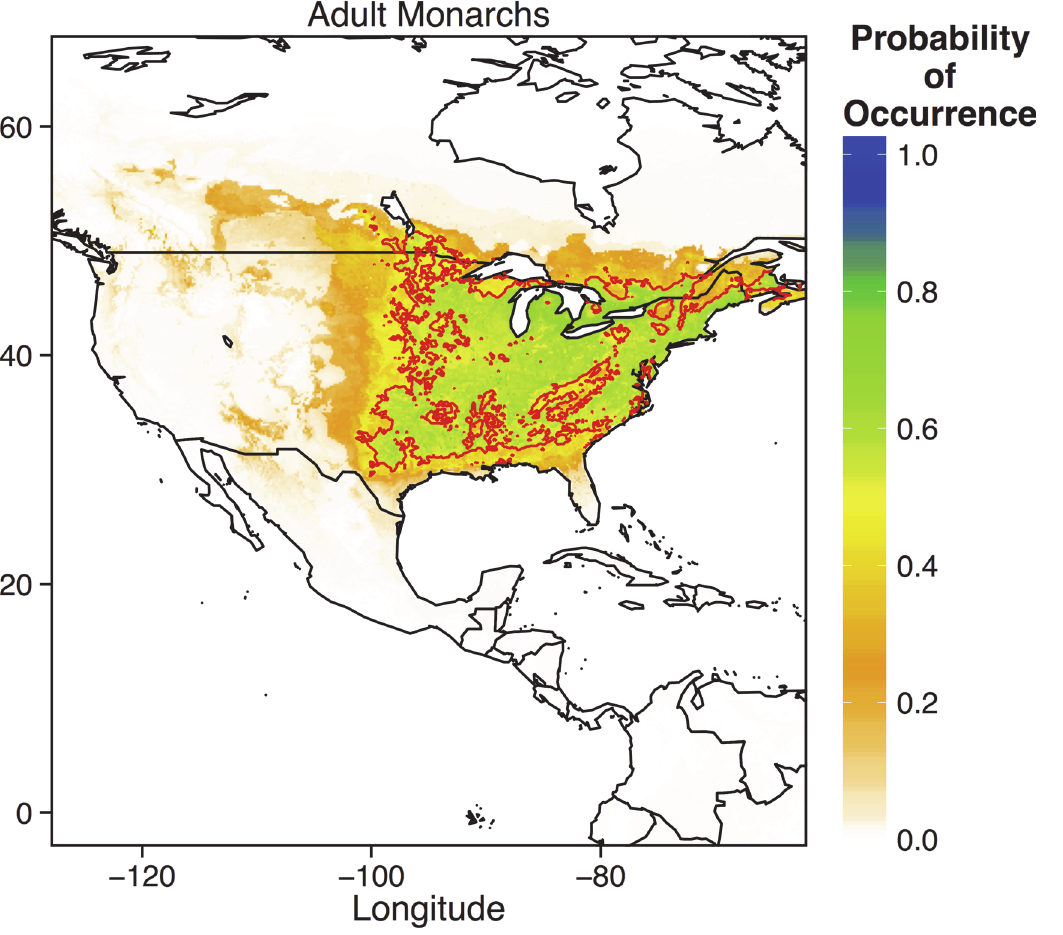
Fig 6. Prediction from the best-fitting MaxEnt model for the probability of occurrence of adult monarchs ( Danaus plexippus ) throughout eastern North America. Thick red lines denote the 0.5 probability contour, such that areas inside the contour have a (cid:1) 0.5 probability of containing